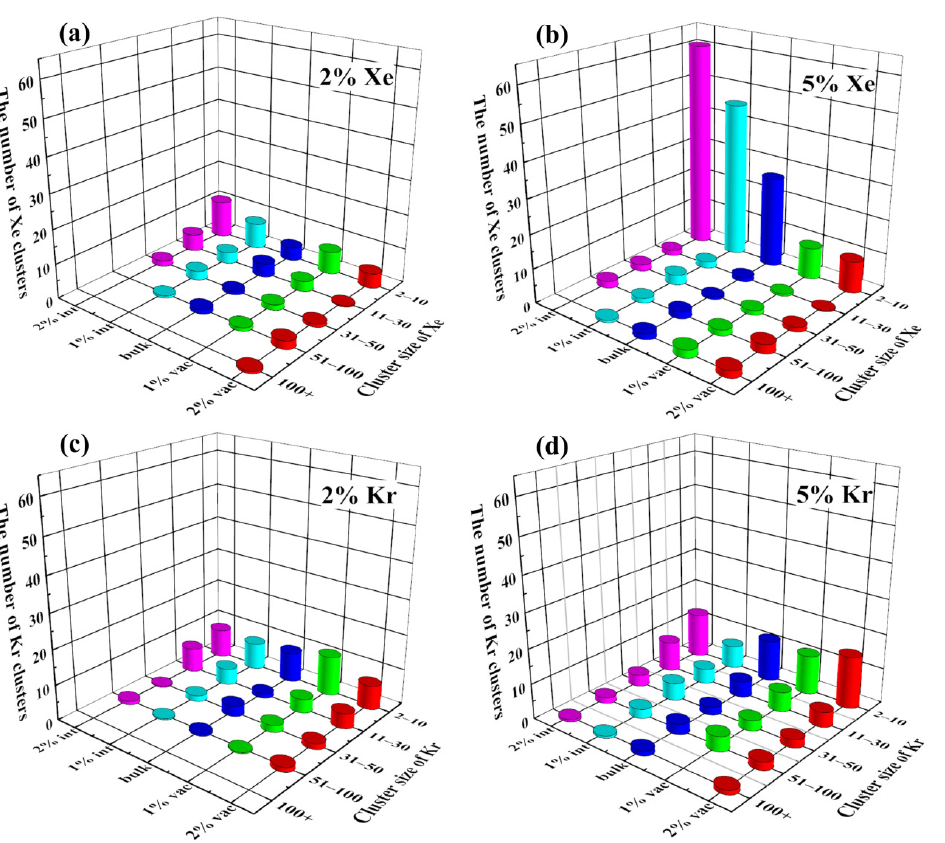
Figure 6. The cluster sizes distribution of ( a ) 2% Xe, ( b ) 5% Xe, ( c ) 2% Kr, and ( d ) 5% Kr in different systems, respectively. The pink, light blue, dark blue, green and red bars are the systems with 2% interstitial concentration, with 1% interstitial concentration, perfect bulk without defects, with 1% vacancies concentration, with 2% vacancies concentration, respectively.